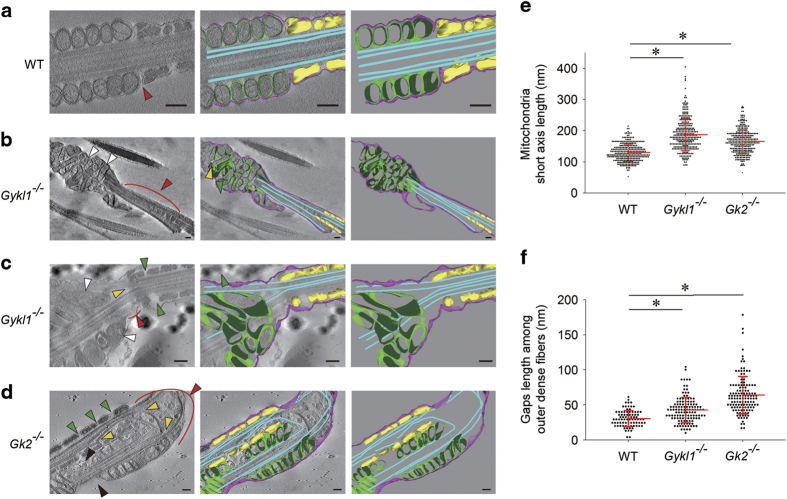
Ultra-structural analysis of the spermatozoa from male Gykl1 and Gk2 mutant mice. (a–d) The spermatozoa were collected from various mice and analyzed by transmission electron microscopy (TEM) coupled with Electron Tomography, which enabled detailed 3D imaging of the midpiece and tail regions. For each group, the middle slice of the electron tomogram is shown on the left, the annotation model on the right, and superimposed tomogram with the annotation model in the middle. Purple indicates the outer cell membrane of the spermatozoa, green the outer membrane of the mitochondria, cyan the doublet microtubule or central microtubule, and yellow the outer dense fibers. White arrows, swollen and misarranged mitochondria. Black arrows, midpiece that lacks mitochondria. Green arrows, gaps between outer dense fibers. Red arrows, gaps between the mitochondrial sheath and outer dense fibers. Yellow arrows, branched or fragile axoneme. Scale bar, 200 nm. (e and f) The length of the mitochondria short axis (e) and the gaps among outer dense fibers (f) in the spermatozoa from wild-type and mutant mice were measured and plotted. Over 300 spermatozoa were counted for each group. Error bars represent s.d. Significance was determined by ANOVA. *P<0.05.